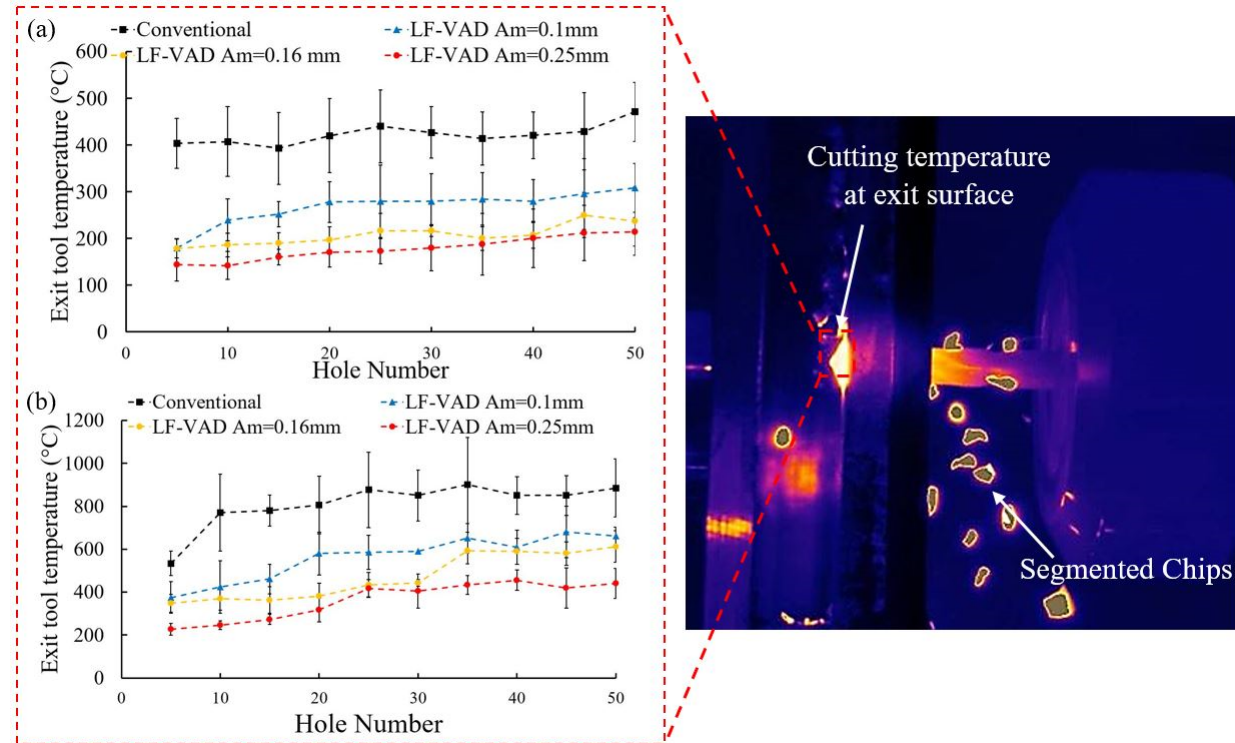
Figure 4. Effect of the tool wear progress on the tool cutting temperature at the exit surface for ( a ) N = 2000 rpm, and ( b ) N = 3000 rpm.